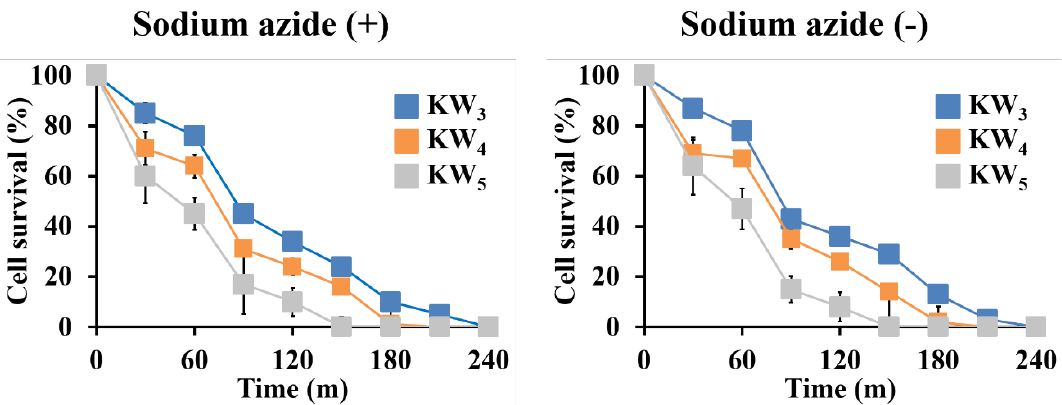
Figure 3. Time-kill-kinetics of the KW n peptides against C. albicans in the absence and presence of sodium azide. The concentrations used were 32 μM for KW 3 , 8 μM for KW 4 and 8 μM for KW 5 . Three biological replicates were run for each test sample, and the recorded values were averaged with the error bars representing the SD. For some data points no error bars can be seen due to the small SD.